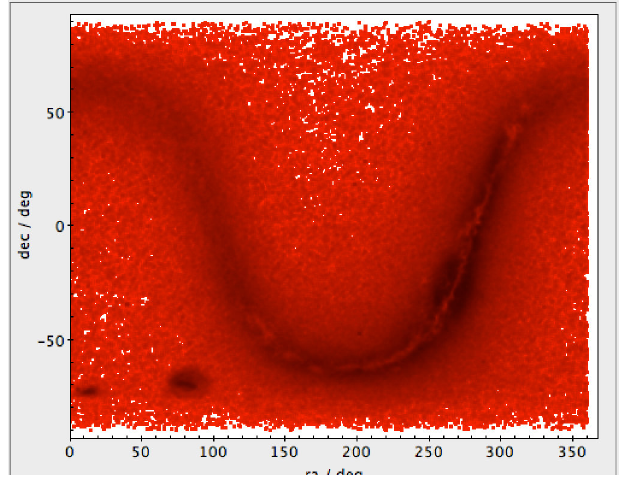
Fig. 61.— Plot of a random sub-sample of Gaia DR2